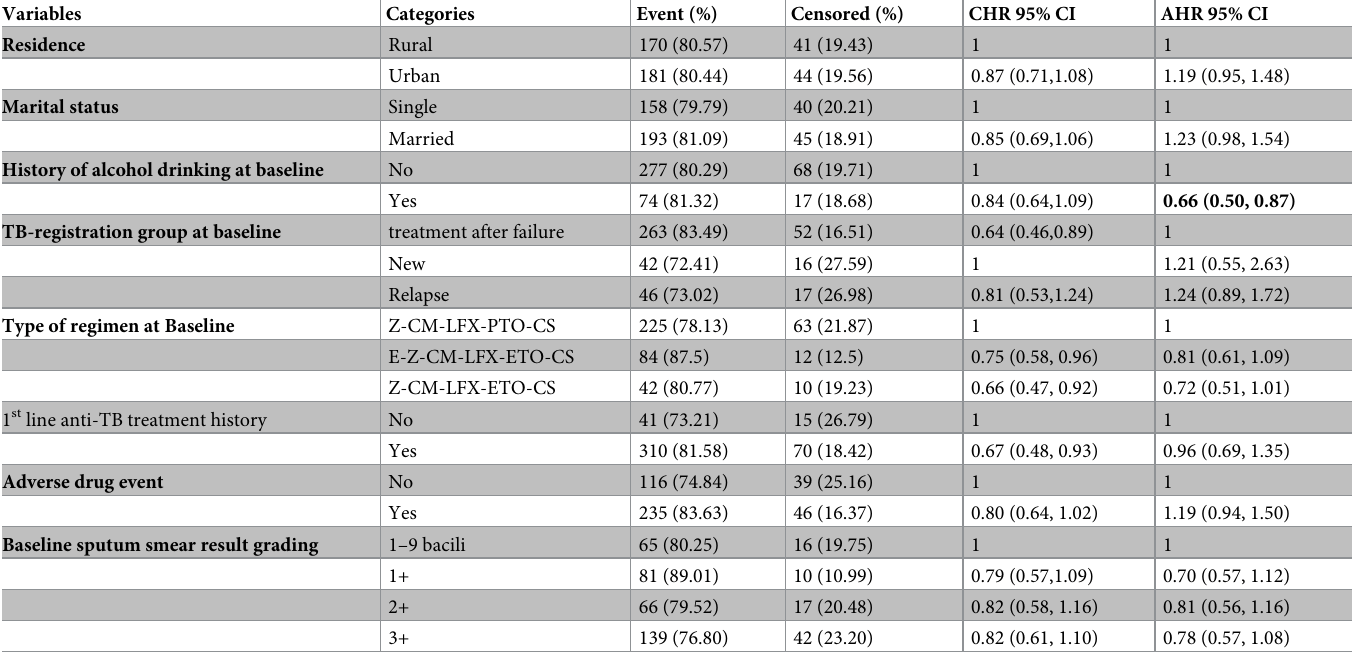
Table 3. Bi-variable and multi-variable cox regression analysis of the predictors for sputum smear conversion among DR-TB patients in North West Ethiopia (N =